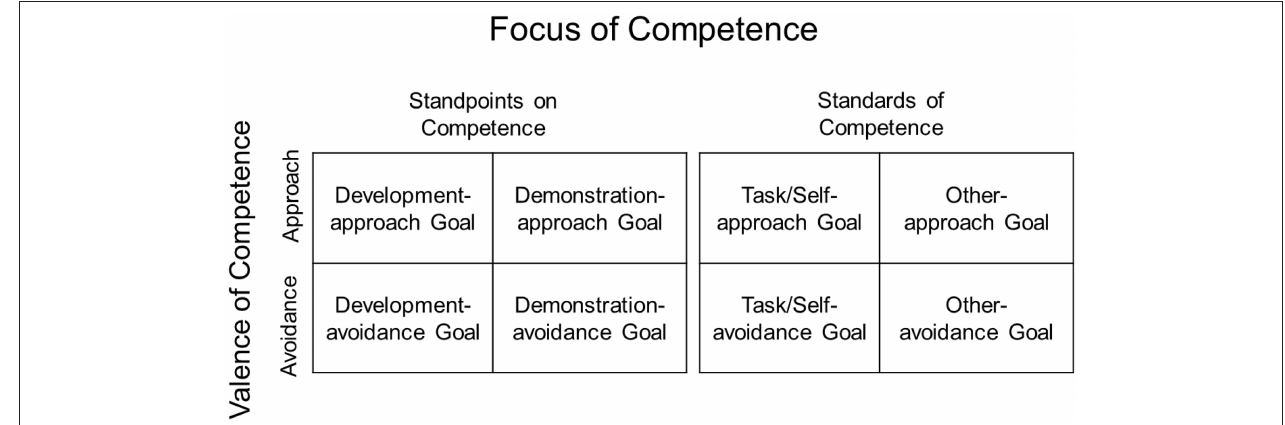
FIGURE 1 | Overview of the components and subcomponents of competence in achievement goal